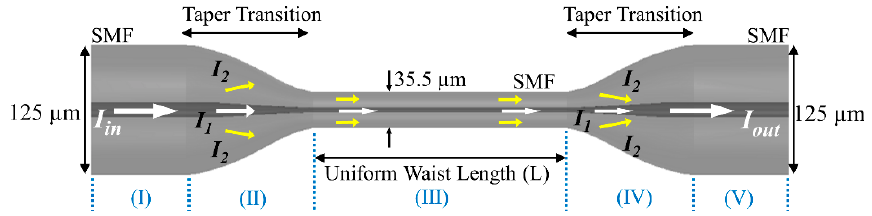
Figure 1. Schematic diagram of the internal structure of a microfiber MZI that was fabricated by employing the long uniform tapering technique.